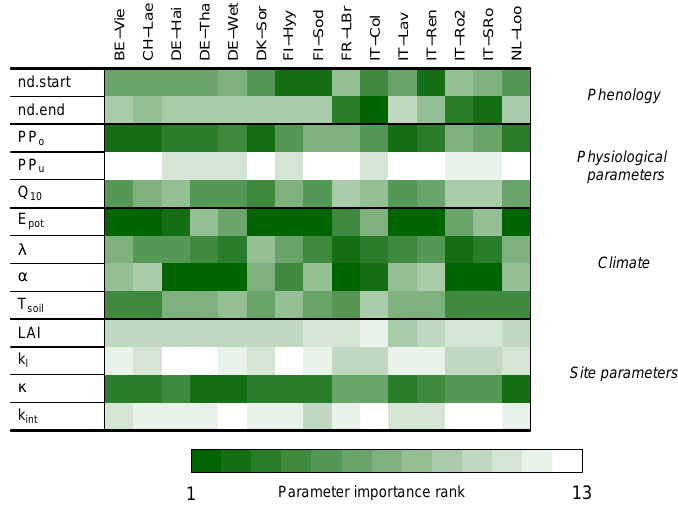
Figure 6. Importance rank of G-For10’s input parameters. The darker the shade of green, the more influential a parameter is for the S r estimates at a given site. The model is most sensitive to perturbations of the physiological parameters of the overstory (PP o ) and poten- tial evaporation ( E pot ) at the cold and temperate sites, whereas variations in mean precipitation intensity ( α ) become more important at Mediterranean sites. Also, variations in soil water holding capacity κ consistently have a medium to high